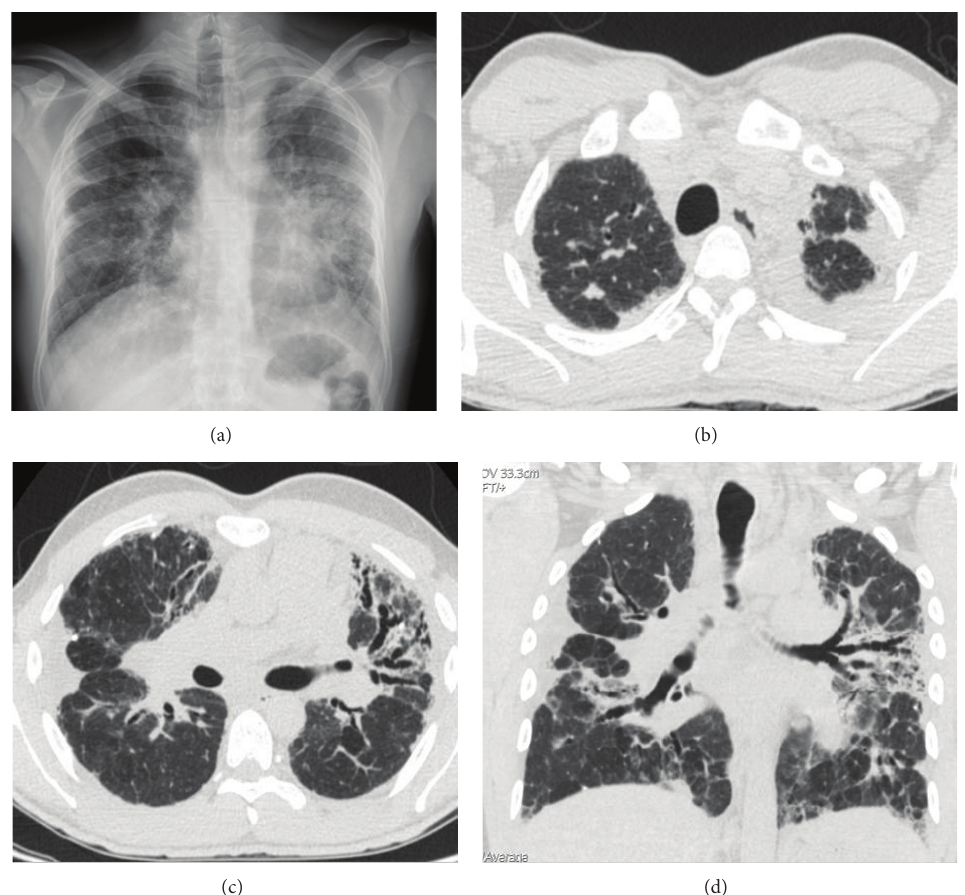
Figure1:Case 1.(a)Chestradiographyshowsbilateralpulmonaryinvolvement,withreticularinterstitialpattern,withmarkedpredominance in the left lung, more prominent on the left and signs of volume loss of both upper lobes with bilateral pleural thickening of apical predominance. (b) Axial high resolution computed tomography (HRCT) scan obtained through apical region shows pleural thickening, much more marked in left apex. (c) Axial HRCT scan at level of carina reveals right side marked pleural thickening and signs of pulmonary fibrosis, mainly in the left upper lobe, with the presence of multiple traction bronchiectasis, superimposed with ground-glass opacities. (d) Coronal HRCT reformatted image shows left apical and lateral right pleural thickening. Note architectural distortion reflecting fibrotic changes, accompanied by traction bronchiectasis and scattered peripheral reticular